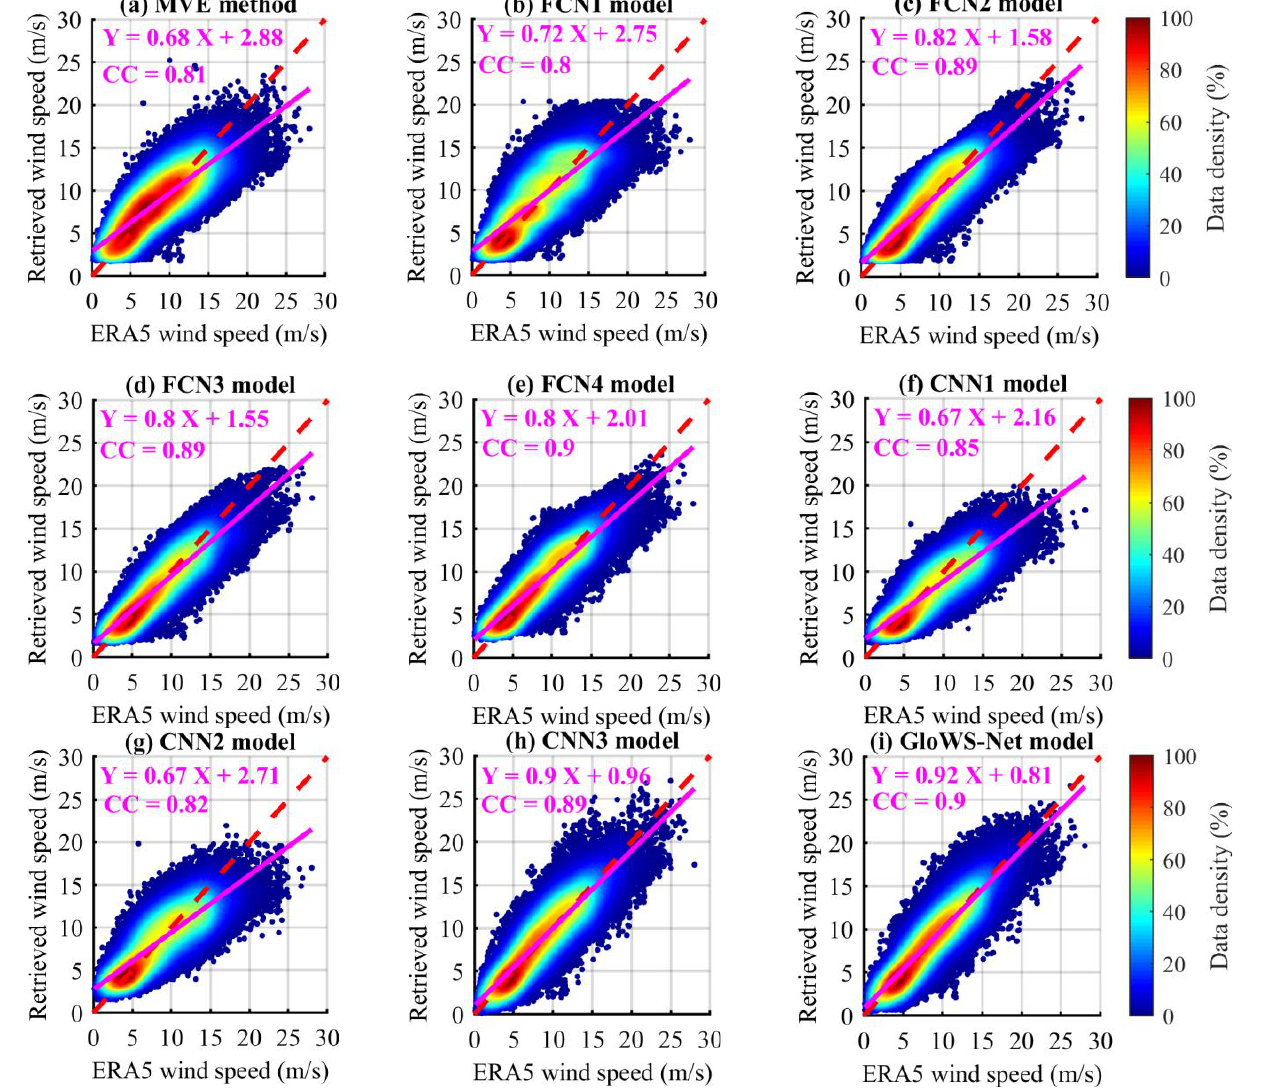
Figure 5. Scatter density plots of retrieved wind speed by different models and ERA5 wind speed.